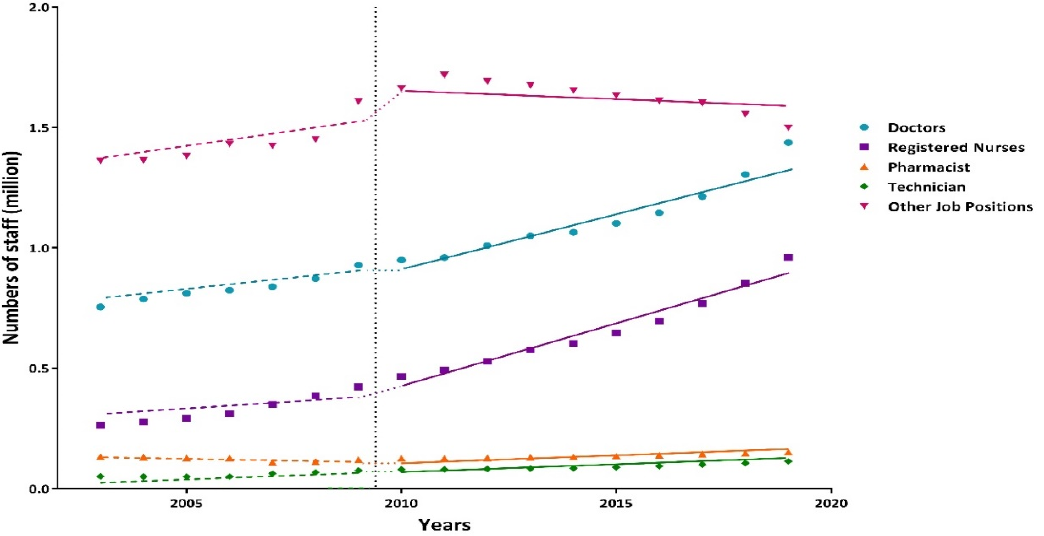
Figure 3. Interrupted time series analysis of human resources in different job positions of Chinese primary health ‐ care institutions from 2003 to 2019.